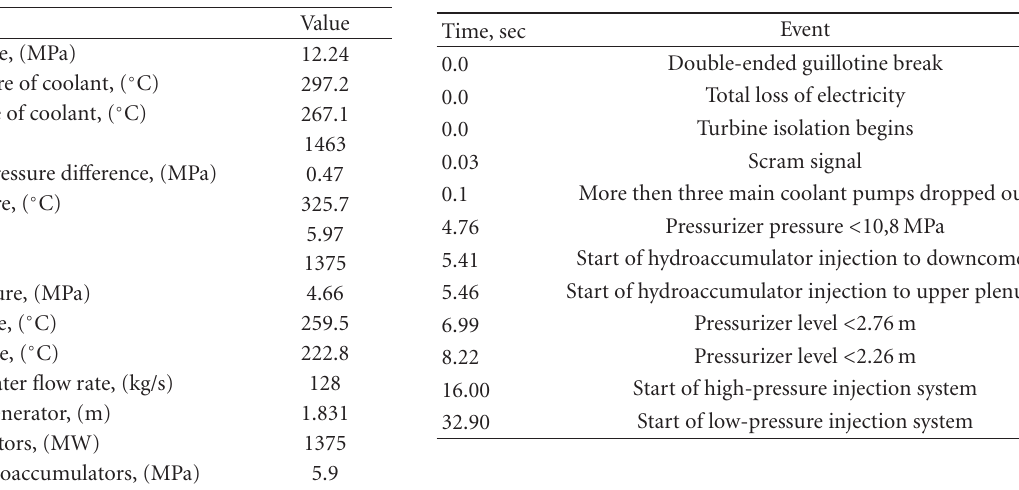
Figure 5: Calculated test facility and NPP MERs for Test 4. (a) Break flow rate, (b) break enthalpy. Table 4: Initial conditions of LB LOCA. Table 5: Chronology of events during LB